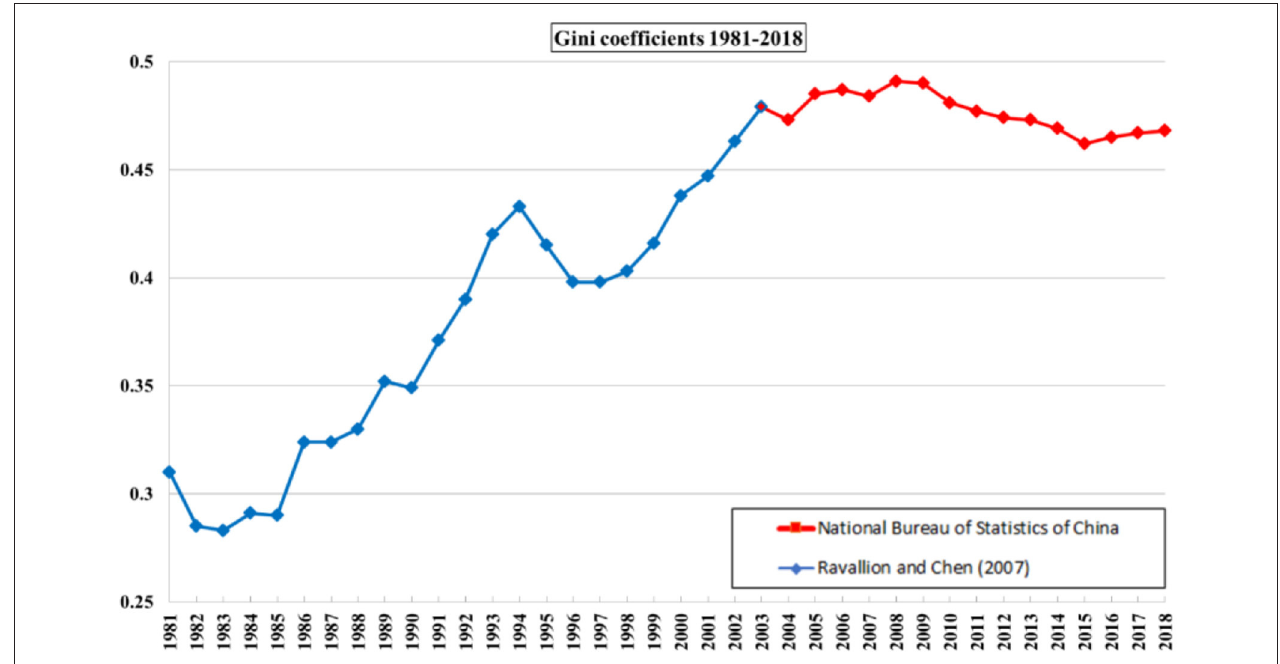
FIGURE 1 | Income inequality in China from 1981 to 2018 measured by Gini coefficients. Source: Ravallion and Chen (32) and NBSC